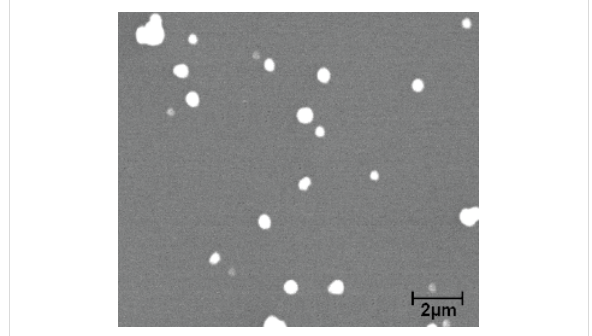
Figure 4: SEM image of spherical Au nanoparticles approximately 500 nm in diameter which are referred to as Au